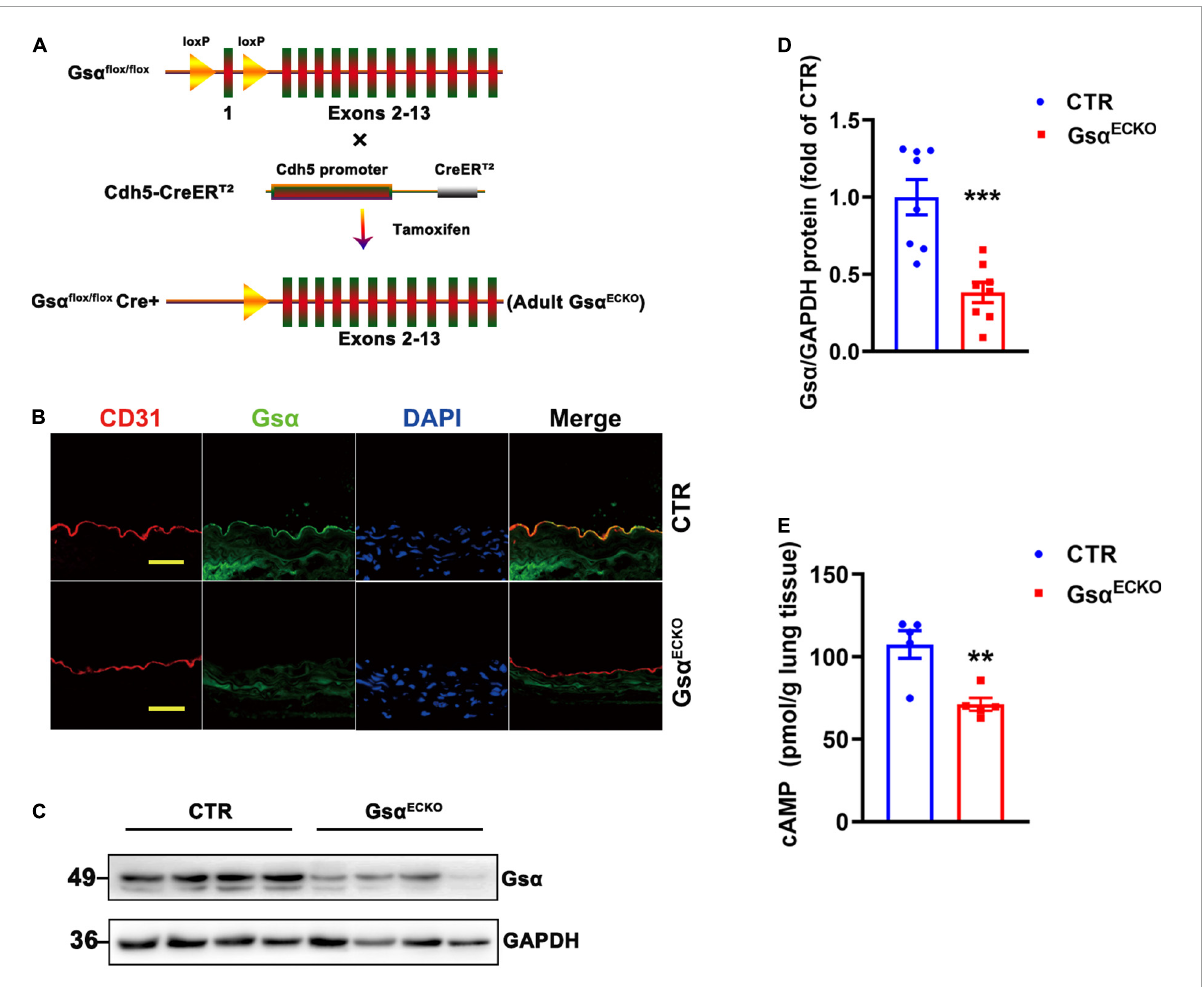
FIGURE1 Generation of endothelia specific-Gs α knockout mice. (A) Schematic diagram of generation of endothelial-specific Gs α knockout mice. (B) Representative immunofluorescence staining for Gs α , CD31 for endothelial cells, and DAPI for nuclei in aortas from control (CTR) and Gs α ECKO mice. Scale bar, 100 µ m. (C,D) Western blot analysis and quantification of Gs α protein in lung tissues of CTR and Gs α ECKO mice. n = 8/group. (E) The cAMP level was measured in lung tissue of CTR and Gs α ECKO mice. n = 5/group. ** P < 0.01, *** P < 0.001 vs. CTR (unpaired Student’s t -test). Data are mean ±